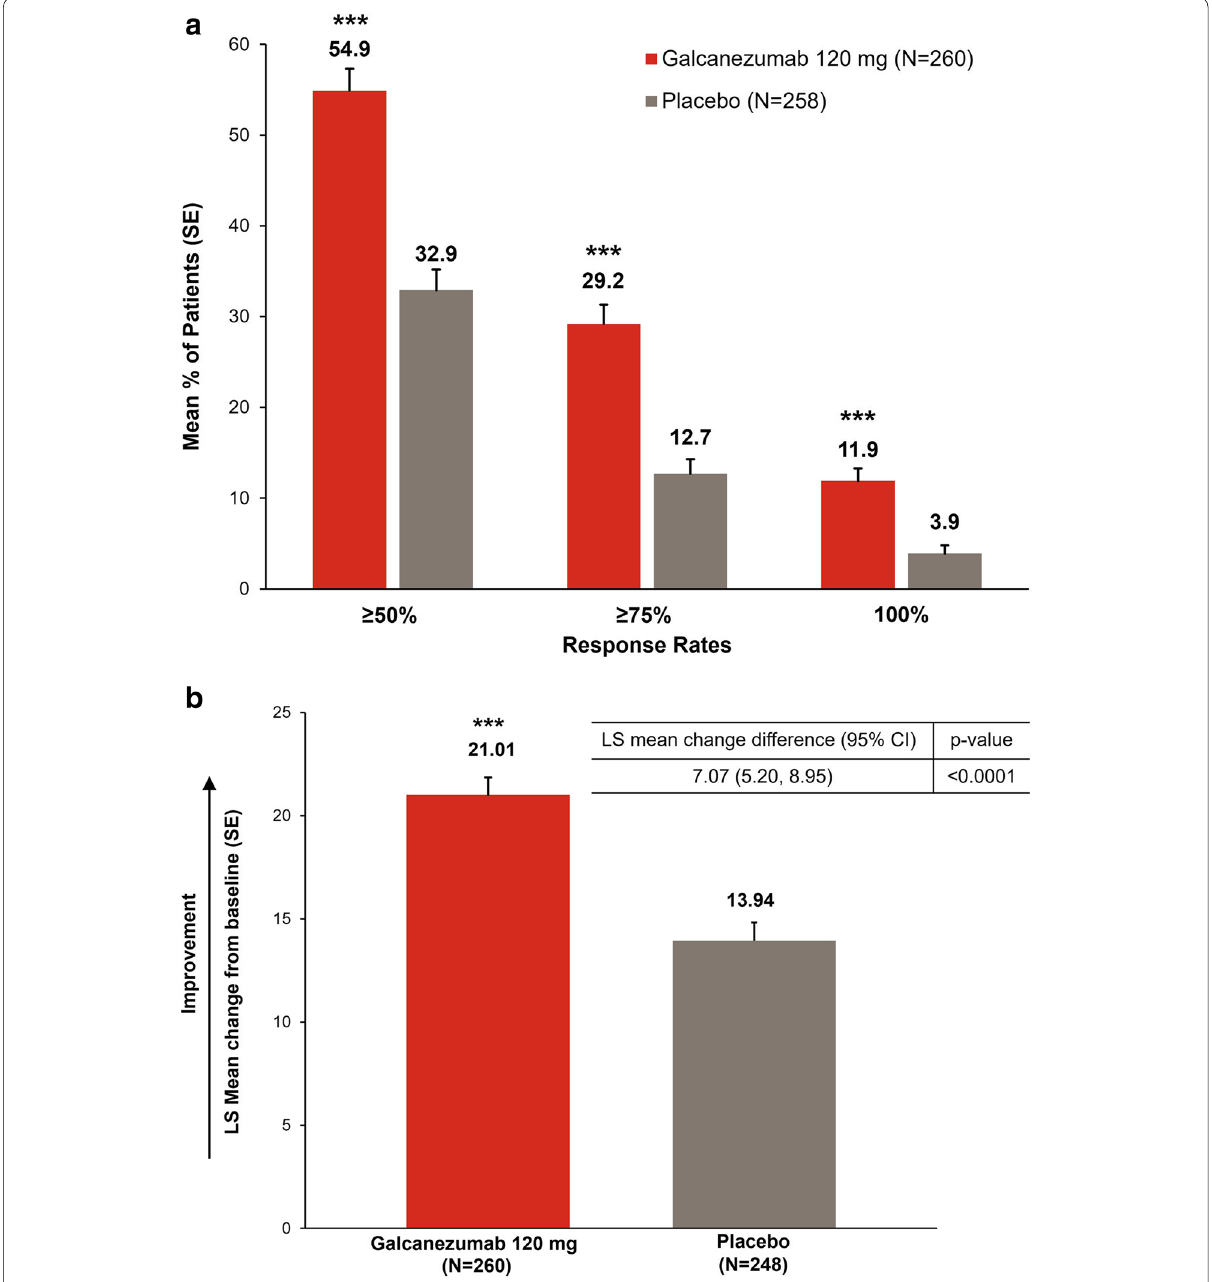
Fig. 4 Key secondary endpoints: a mean percentage of patients with mean change in the Migraine-Specific Quality of Life Questionnaire Role Function-Restrictive CI, confidence interval; LS, least squares; SE, standard error. *** p < 0.0001 versus